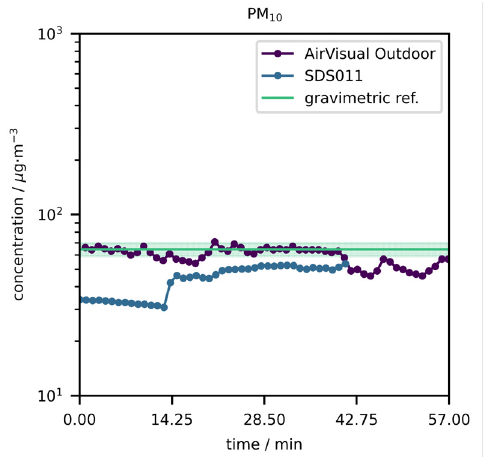
Figure 5. PM 10 mass concentrations reported by the AirVisual Outdoor and SDS011 as a function of time (model aerosol 2). The green line refers to the average mass concentration over the whole measurement period according to the gravimetric reference method, while the shaded green area designates the expanded uncertainty ( k = 2; 95% confidence interval) thereof.